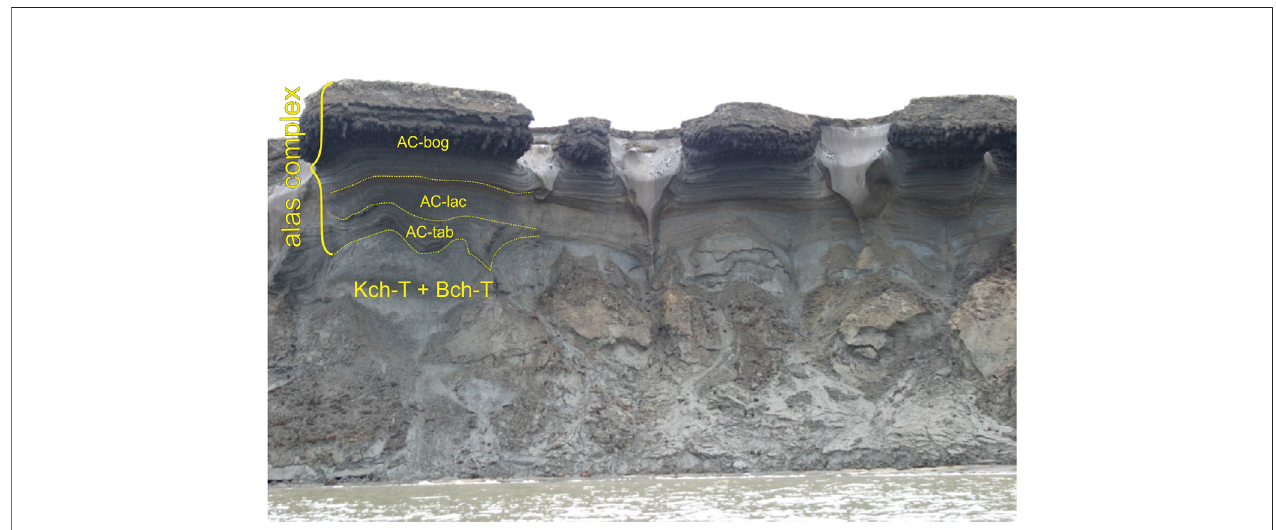
FIGURE 11 | Typical structure of the Holocene Alas Complex with taberal (AC-tab), lacustrine (AC-lac), and lacustrine-boggy (AC-bog) facies. The coastal section of the alas depression is located on Bol`shoy Lyakhovsky Island. Kch-T + Bch-T — taberated deposits of Kuchchugui and Bychchagy Suites. The height of the outcrope is 12 m.